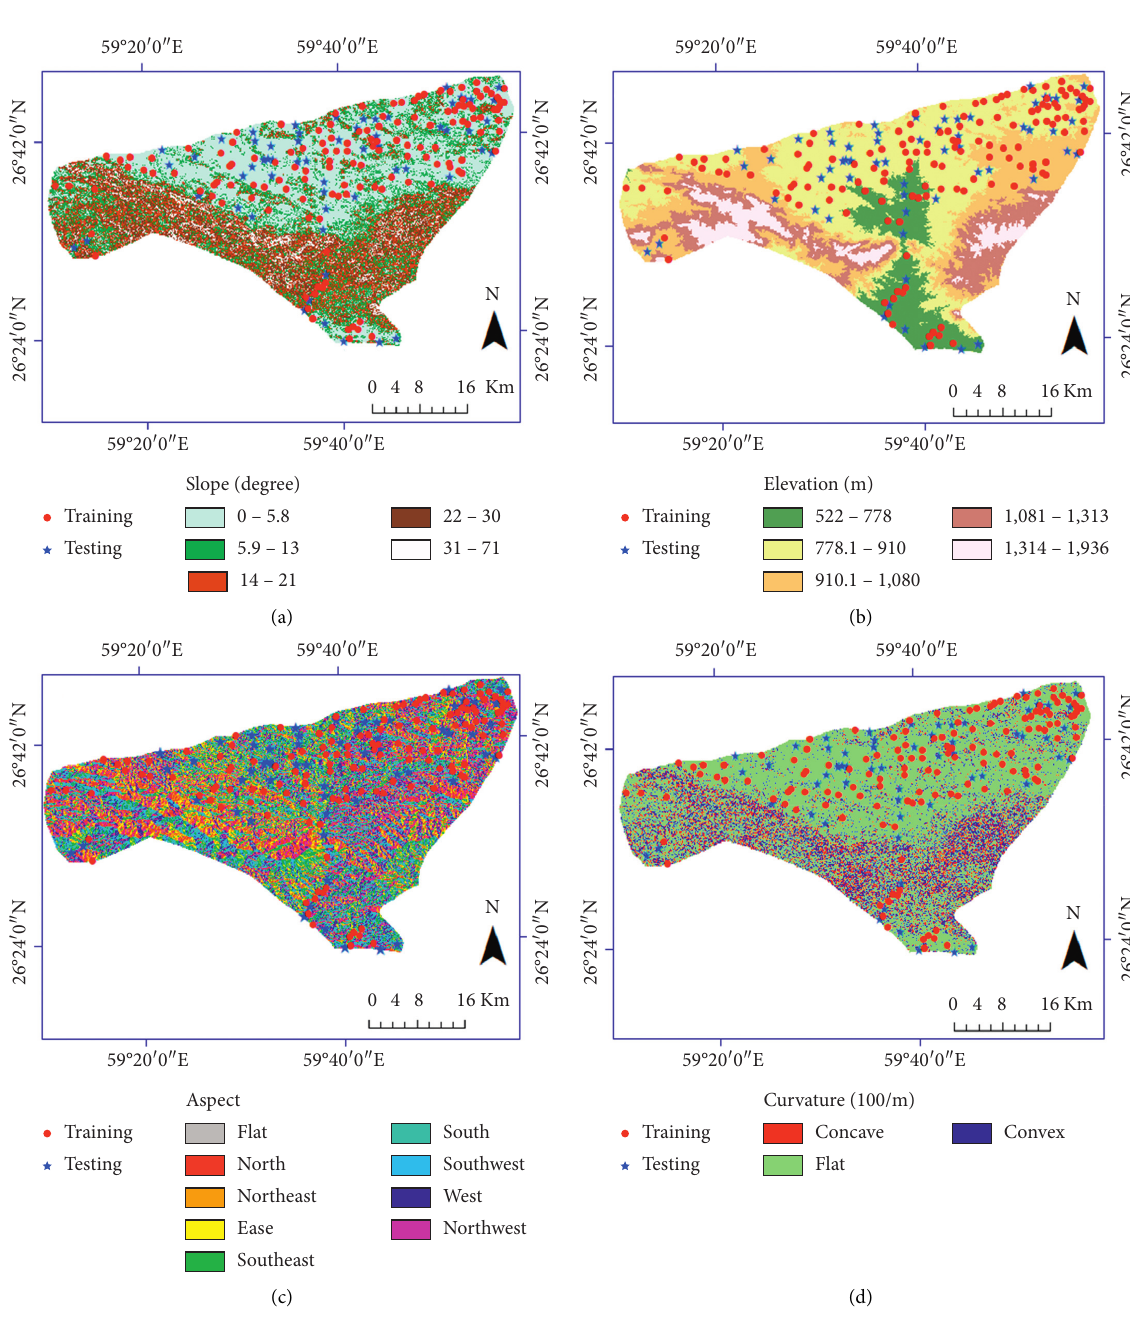
Figure 4: (a) slope. (b) Elevation. (c) Aspect. (d)